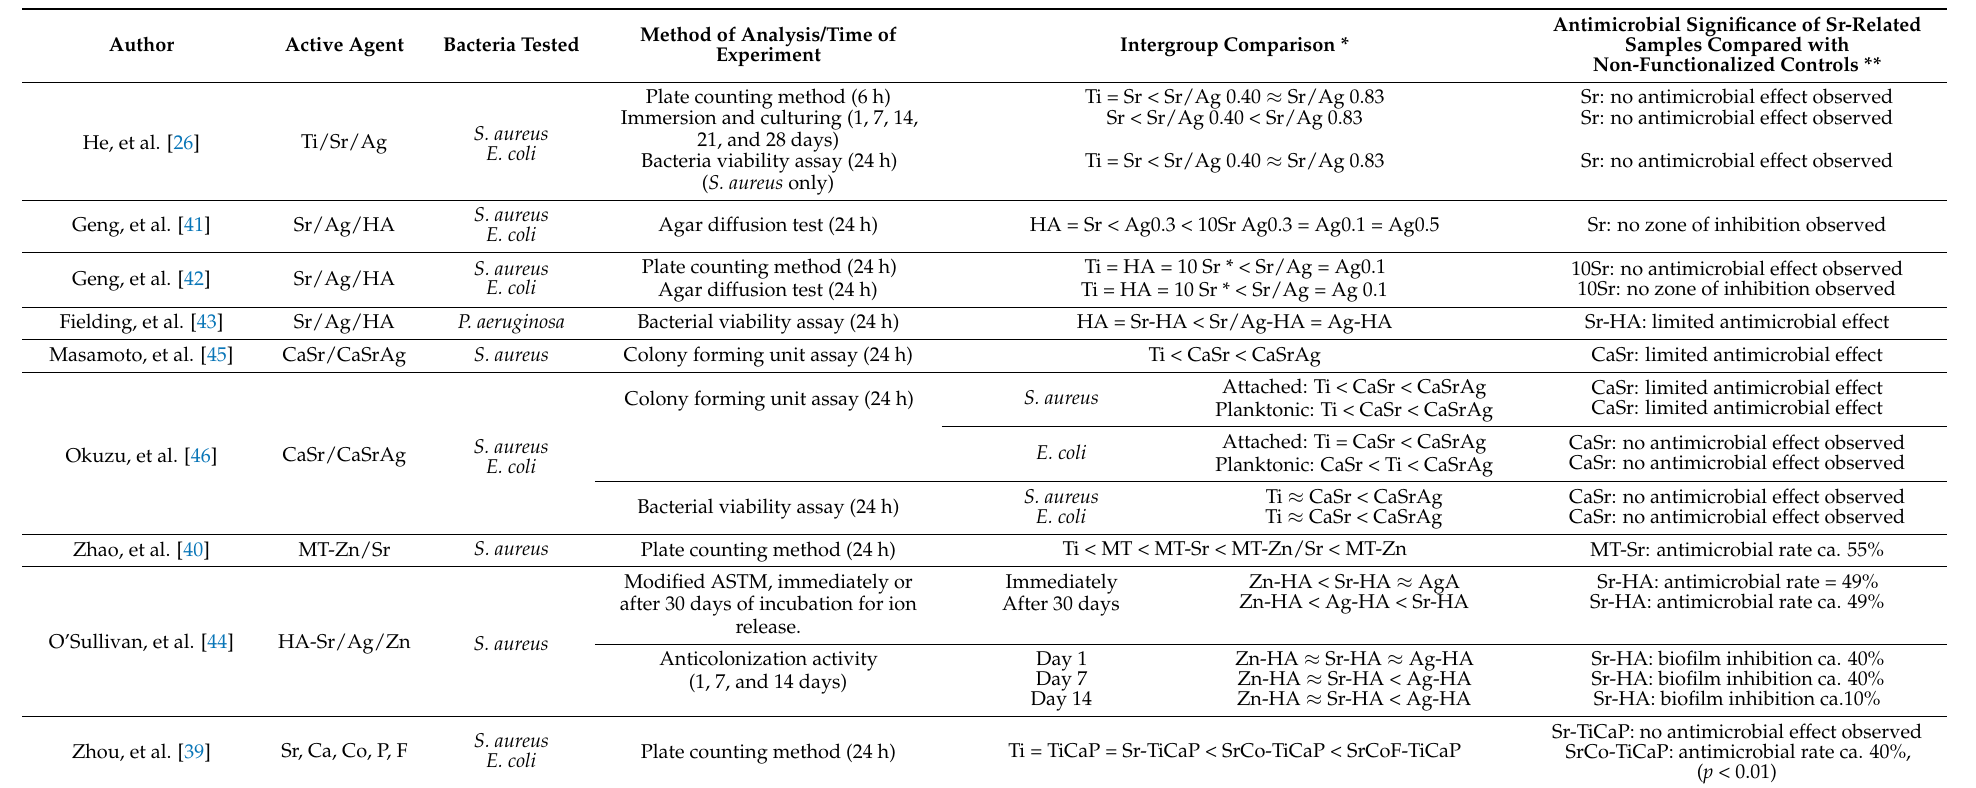
Table 2. Antimicrobial outcome of coated Ti